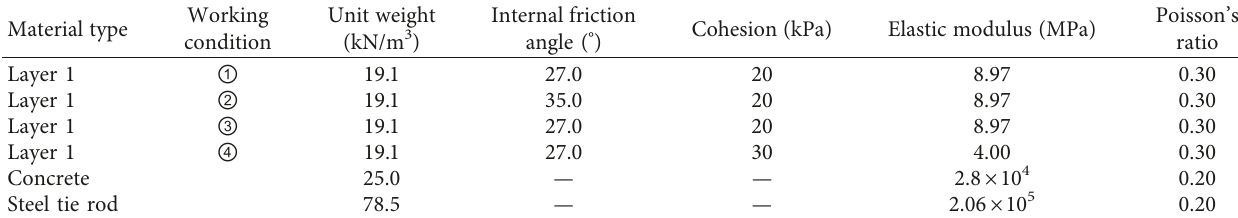
Table 1: Parameters of soil mass, wall, and drawbar